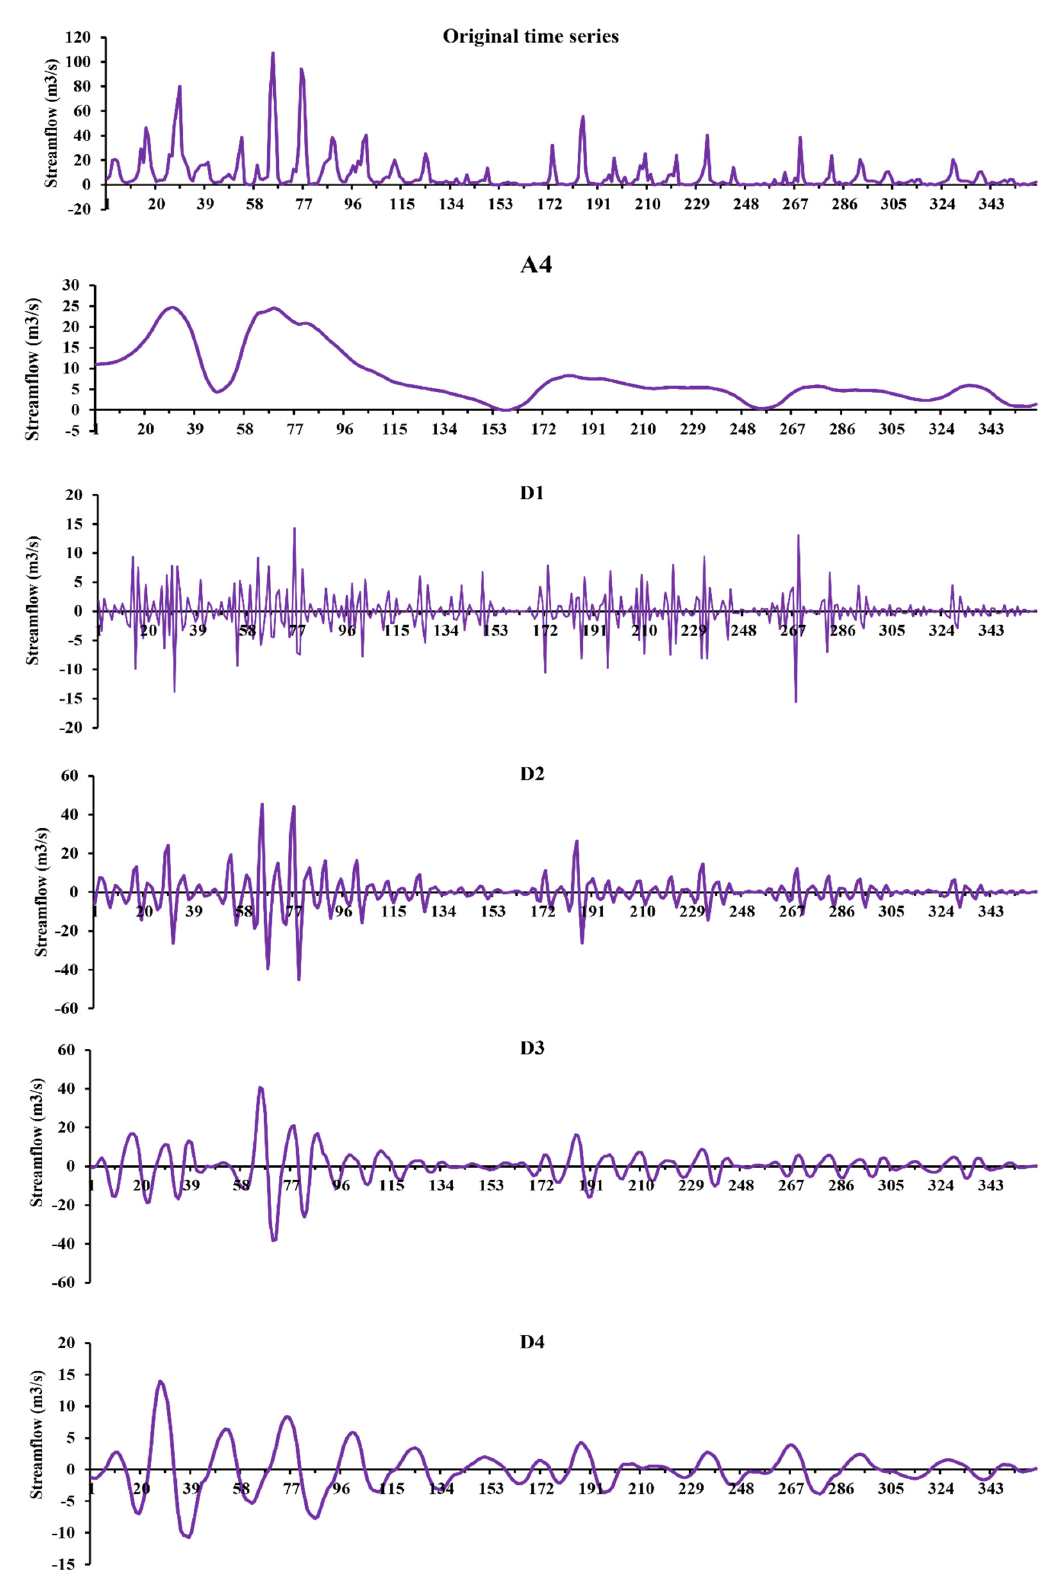
Figure 3. The approximation ( A4 ) and detail ( D1 – D4 ) components of the monthly streamflow time series in the Akhola station.